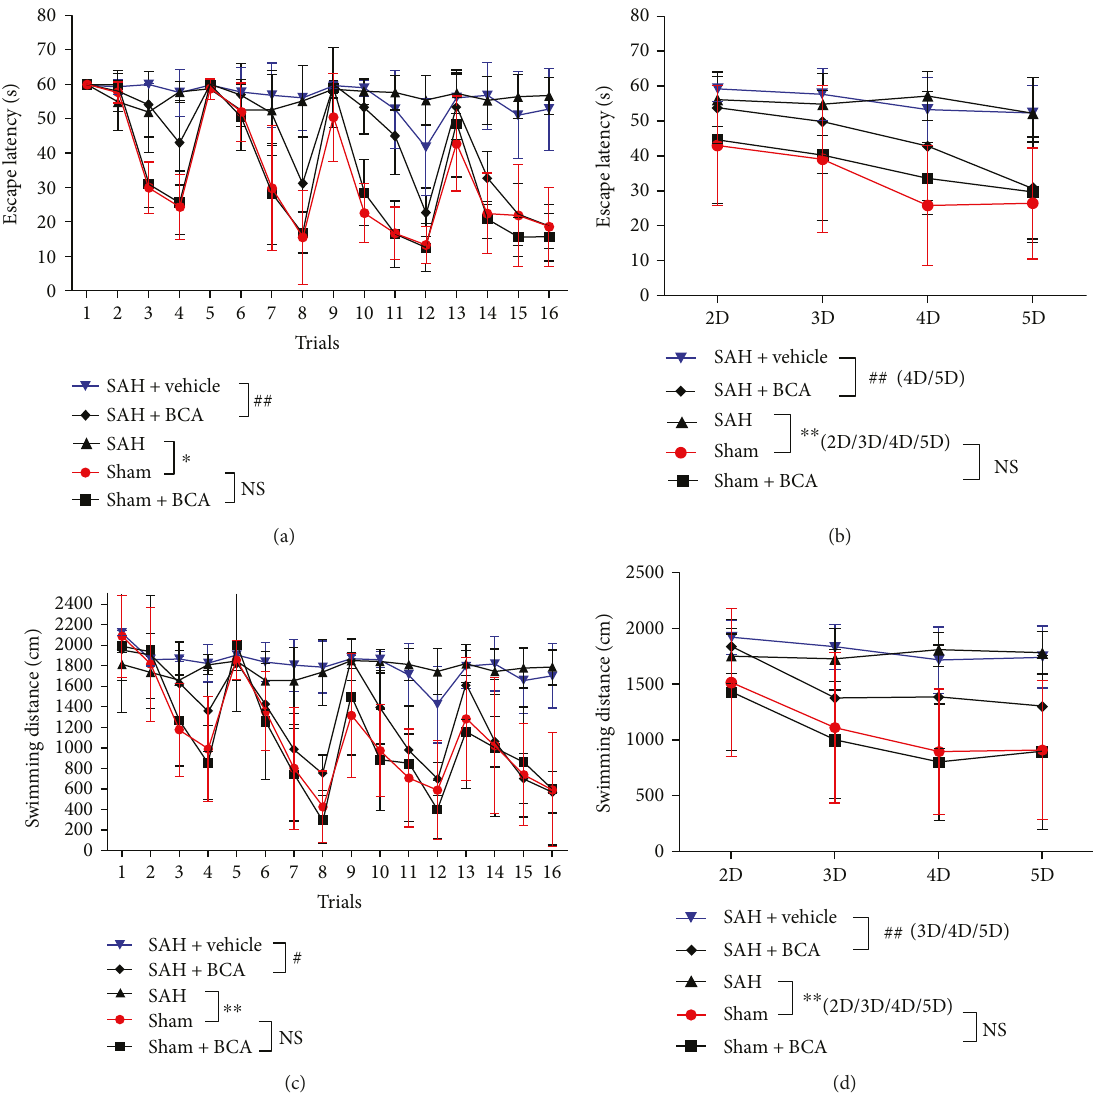
Figure 10: BCA reduced the escape latency (a, n = 8 , ∗ P < 0 05 and ## P < 0 01 , one-way ANOVA) and traveled distance (c, n = 8 , ∗∗ P < 0 01 and # P < 0 05 ) in 16 trials post SAH. In addition, the averaged data showed signi fi cantly shorter escape latency (b, n = 8 , ∗∗ P < 0 01 and ## P < 0 01 , one-way ANOVA) on day 4 and day 5 and traveled distance (d, n = 8 , ∗∗ P < 0 01 and ## P < 0 01 , one-way ANOVA) on day 3, day 4, and day 5 in the BCA treatment